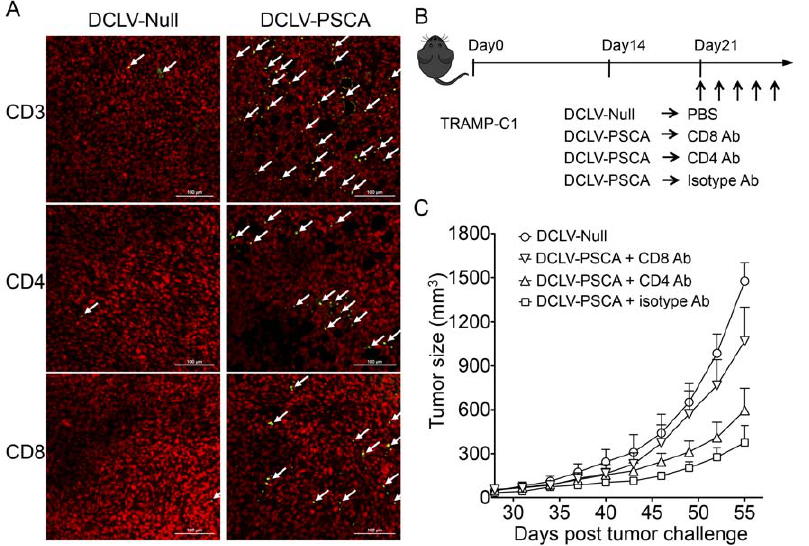
Figure 4. CD8 + /CD4 + T cell-dependent immune protection against TRAMP-C1 tumors induced by DC-LV-PSCA immunization. (A) Infiltration of T cells into tumor tissues. TRAMP-C1 tumors from tumor-bearing mice were excised 3 weeks post-immunization, paraffin-embedded, and stained for immunofluorescence-conjugated CD3, CD4 and CD8 antibody (green color as indicated by white arrows) together with nuclear staining (red color). Representative images showing CD4 + and CD8 + T cells infiltrated to tumor tissues from DCLV-PSCA-immunized mice as compared to those of DCLV-Null-immunized mice. (B) Four groups of male C57BL/6 mice (n=8 for each group) were transplanted with 5 6 10 5 TRAMP-C1 cells subcutaneously at day 0. Fourteen days later, 3 groups were immunized with DCLV-PSCA, while the other group was immunized with mock vector DCLV-Null. Two groups of mice from the DCLV-PSCA-immunized groups were subjected to CD4 + or CD8 + T cell depletion by injecting CD4- or CD8-depletion antibody intraperitoneally. (C) Tumor volume for each group of mice was monitored. Error bars represent SEM. All experiments were repeated twice and the representative data is shown.